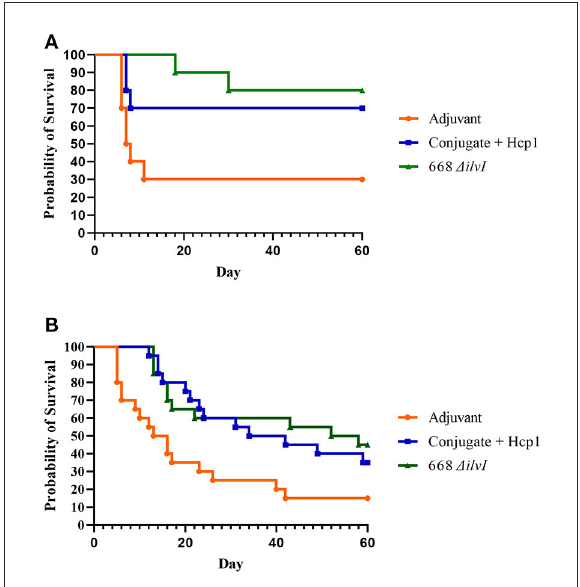
FIGURE5 (A) Survival curves of vaccinated and control C57BL/6 mice ( n = 20/group) challenged with Bm FMH by the aerosol route. Mice were exposed to 4 LD 50 or 11 LD 50 in two separate aerosol exposures of ten mice per group. (B) Survival curves of vaccinated and control C57BL/6 mice ( n = 20/group) challenged with Bp MSHR5855 by the aerosol route. Mice were exposed to inhaled doses of 11 LD 50 or 12 LD 50 in two separate aerosol exposures of ten mice per